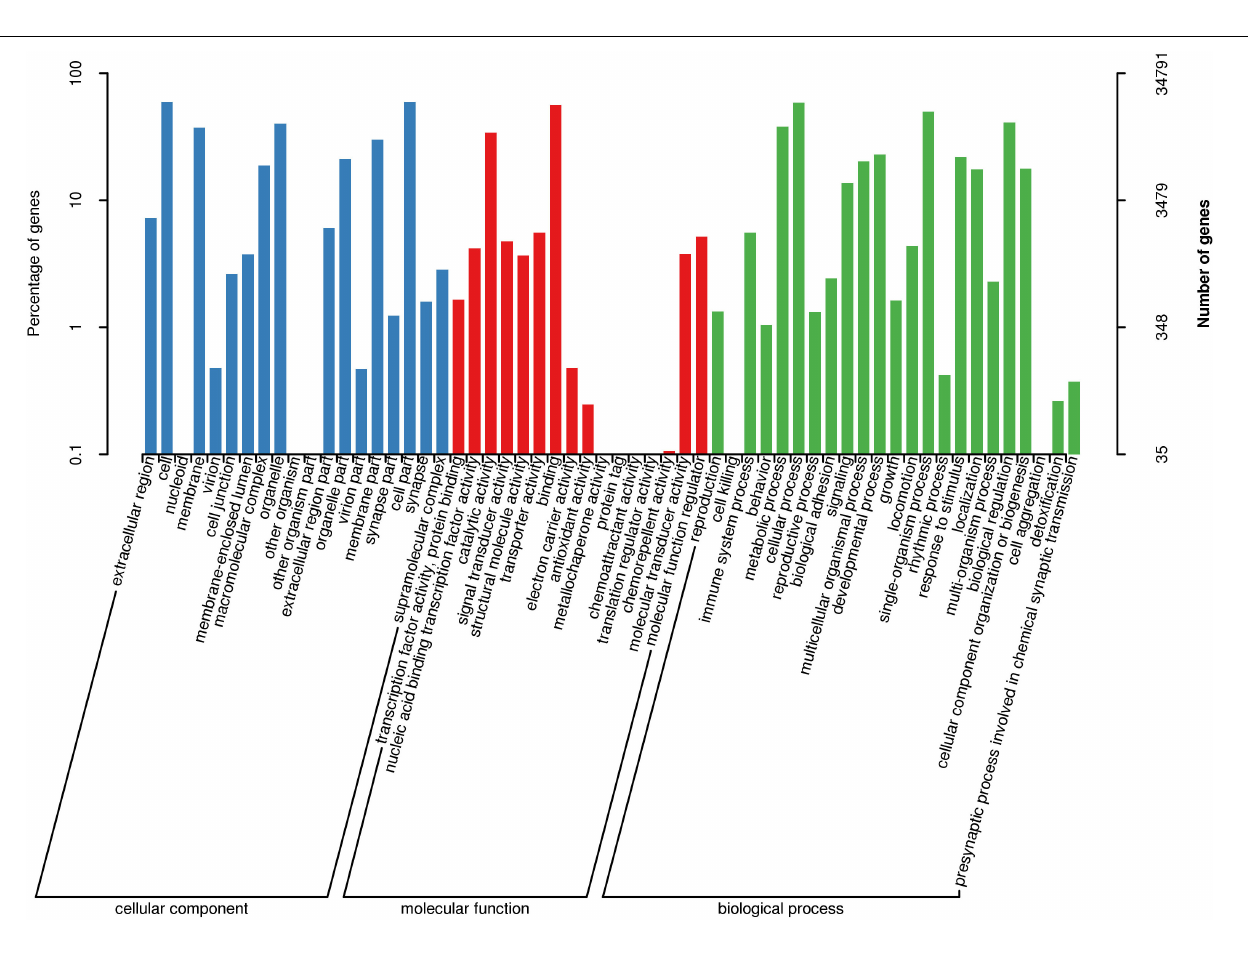
FIGURE 1 | GO classification of non-redundant transcripts in bone tissues of bighead